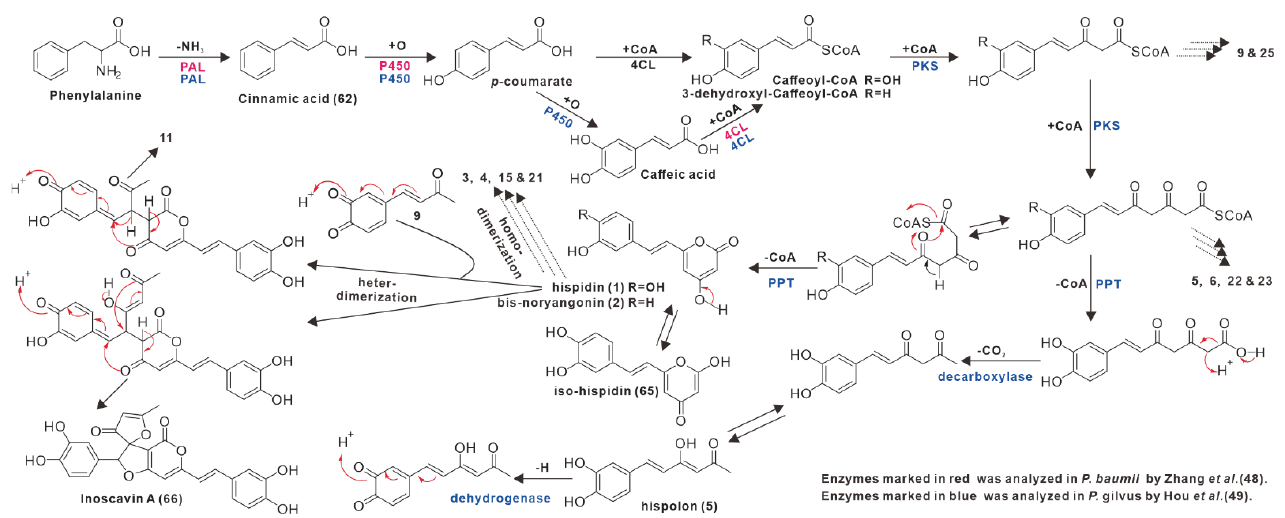
Figure 8. Proposed biosynthesis pathways for styrylpyrones in Inonotus and Phellinus fungi.